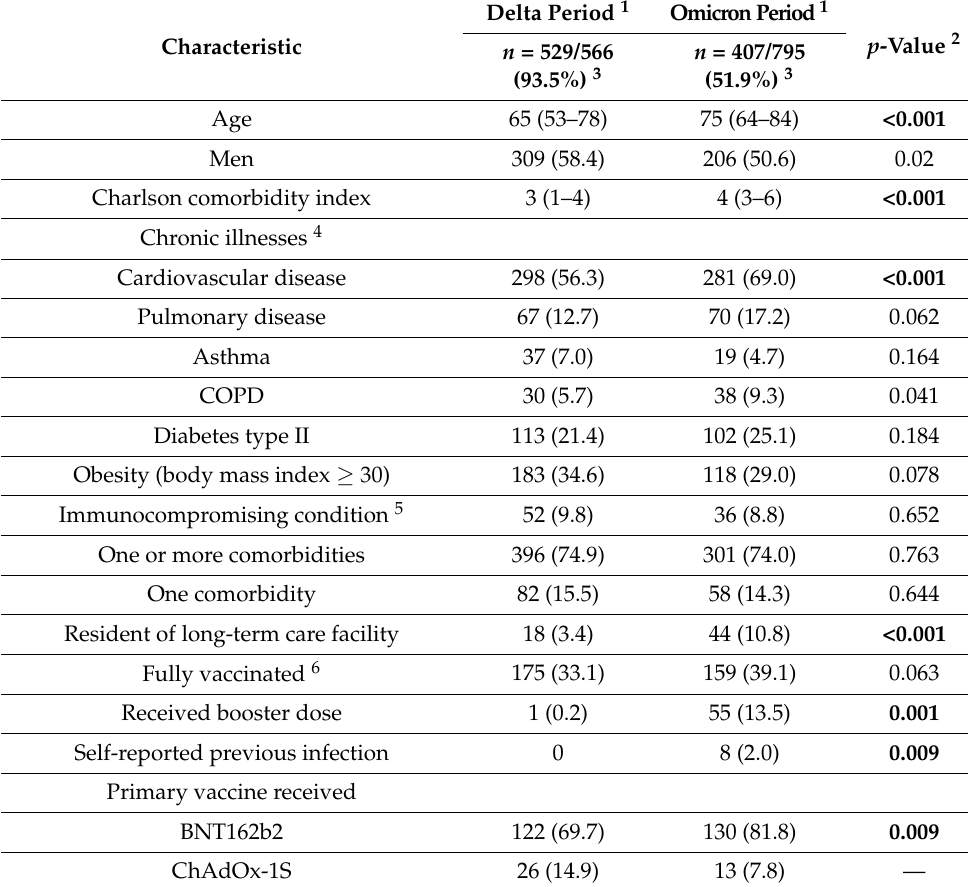
Table 1. Characteristics of patients hospitalized for COVID-19 by study period.